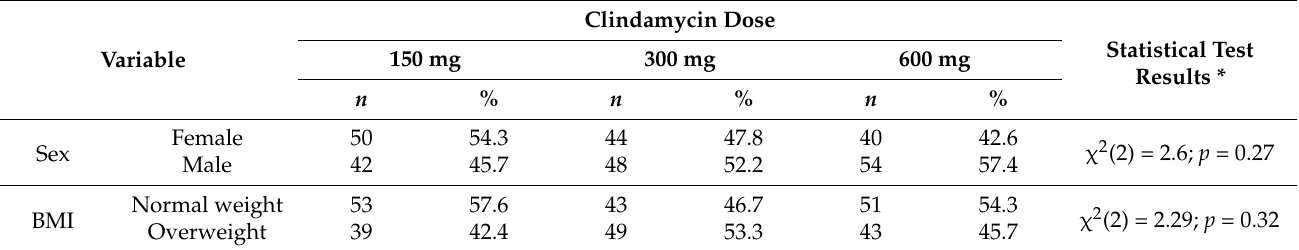
Table 1. Patient characteristics.